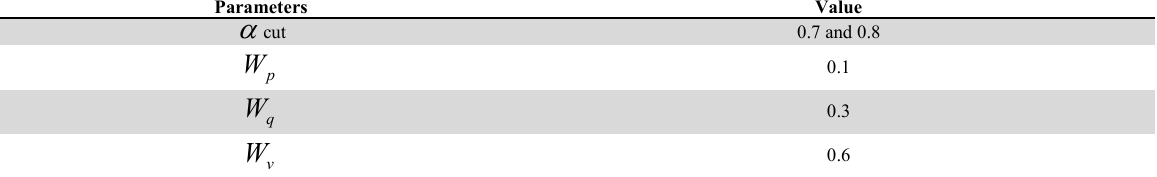
The initialization of the parameters used in the FRC algorithms